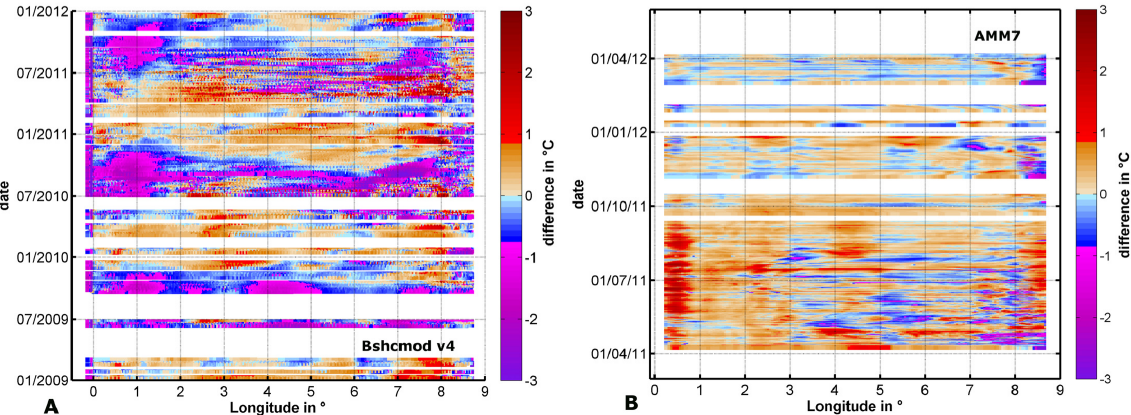
Figure 5. Differences in water temperatures for the TorDania transect (left side BSH–TorDania 2009–2011, right side AMM7–TorDania 2011–2012). The eastern England coast is located on the left side, the German Bight on the right side. Positive values indicate model overestimation. Differences are statistically significant beyond ± 0.84K (2-fold SD of FerryBox, in red and purple colours).